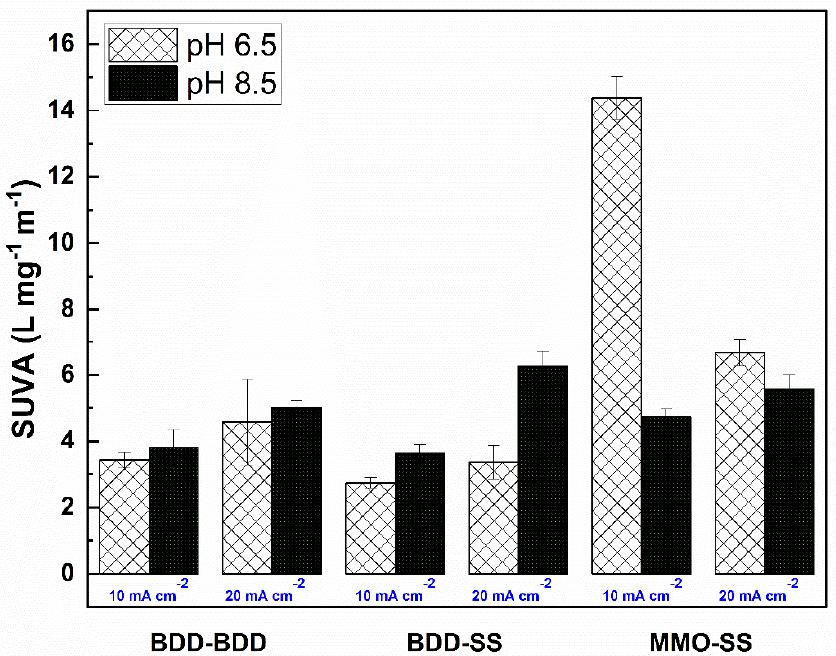
Figure 4. SUVA values of Suwannee River NOM after 120 min treatment using BDD and MMO electrodes at pH = 6.5 and 8.5 and current densities of 10 and 20 mA cm − 2 . Error bars show standard deviation.